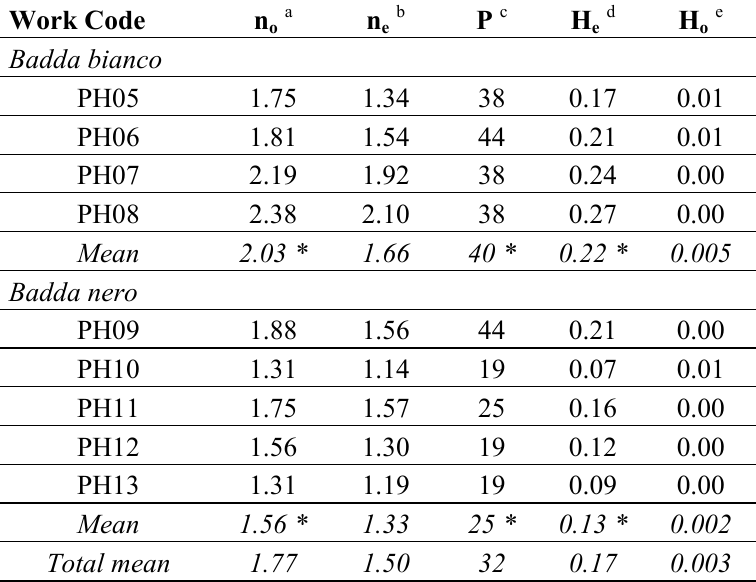
Table 2. Genetic diversity statistics relating to Simple Sequence Repeats (SSR) markers for each accession of “Badda” bean examined.